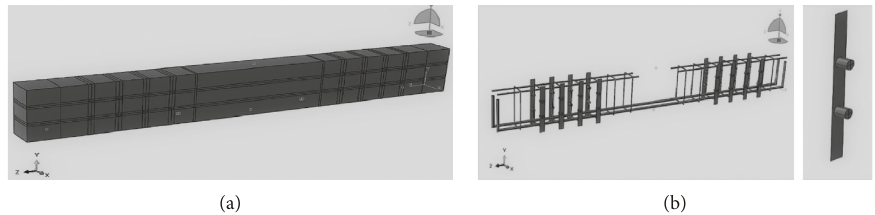
Figure 1: Beam modeling in ABAQUS: (a) 3D modeling of beam; (b) rebar, plate, and embedded connector